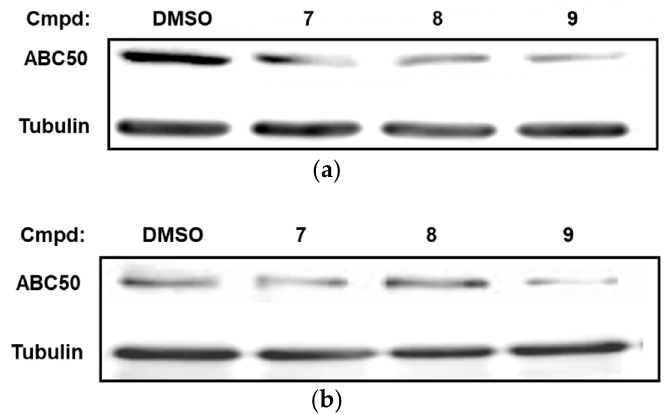
Figure 8. The effect of dicarboximide-based proteolysis-targeting chimeras (PROTACs) on the ABC50 protein in the ( a ) K562 or ( b ) HeLa cells. Cells were incubated with compounds for 96 h and the ABC50 was detected by Western blotting. Compounds 7 and 9 were used at 30 μ M, 8 was used at 15 μ M, DMSO 1% (control). Representative blots from at least 3 independent experiments are shown.